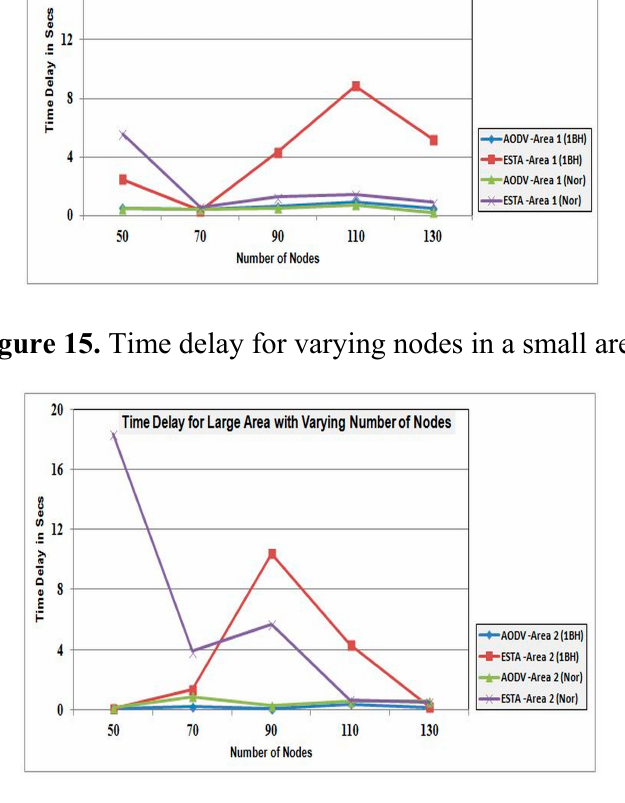
Figure 16. Time delay for varying nodes in a large